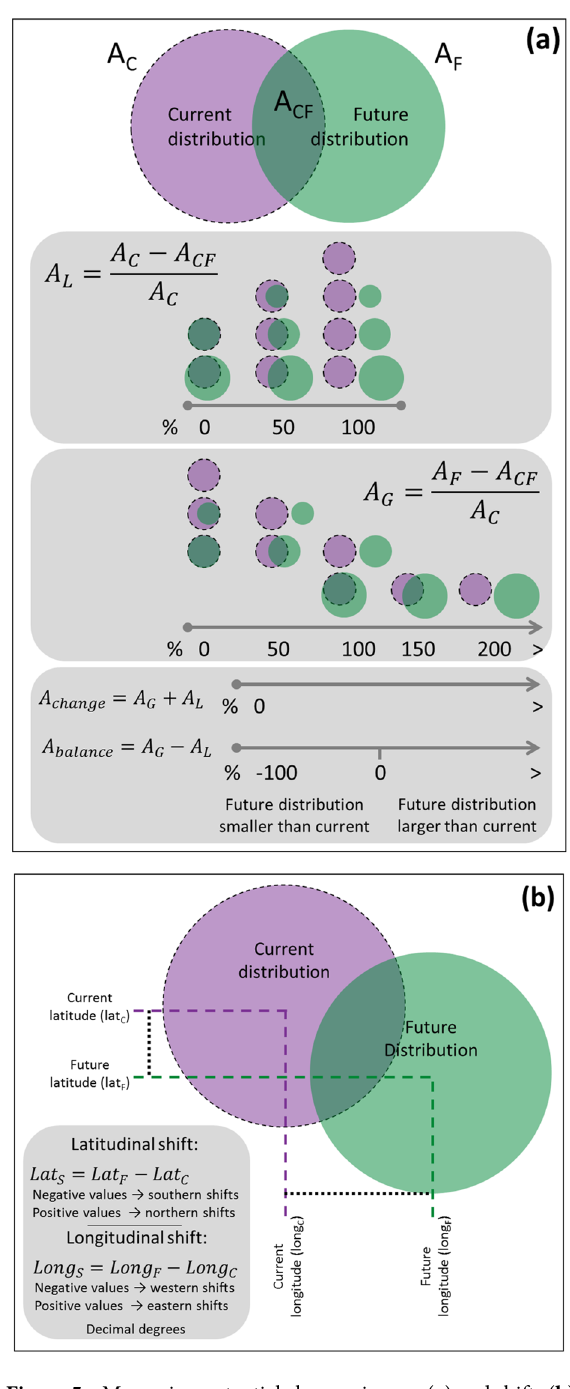
Figure 5. Measuring potential changes in area ( a ) and shifts ( b ) in species’ distributions due to climate change. Area of the current ( A C ) and the future ( A F ) distributions, area of the intersection between the current and future distributions (A CF ), relative area loss in the future ( A L ), relative area gain in the future ( A G ), relative total change in the area ( A change ), relative balance in gain and loss ( A balance ), latitudinal shift ( lat S ), and longitudinal shift ( long S